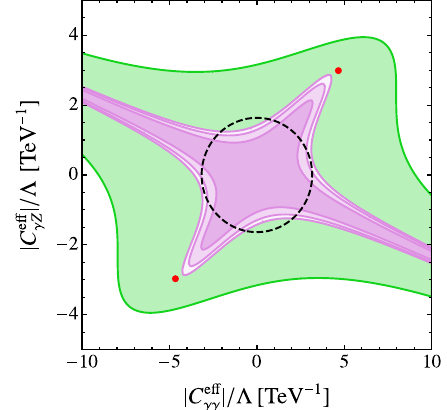
Fig. 12 Allowed regions in the parameters space of the Wilson coef- ficients C eff γγ − C eff γ obtained from projections for the two-parameter Z global electroweak fit at 68% CL, 95% CL and 99% CL at FCC-ee √ s = 14TeV (green). For the (violet) and at 95% CL for the LHC at parameter space within the dashed black contour, the FCC-ee measure- ment of α( m Z ) is within its projected errors at 95% CL [99]. The red dots represent the best fit points based on the current electroweak fit